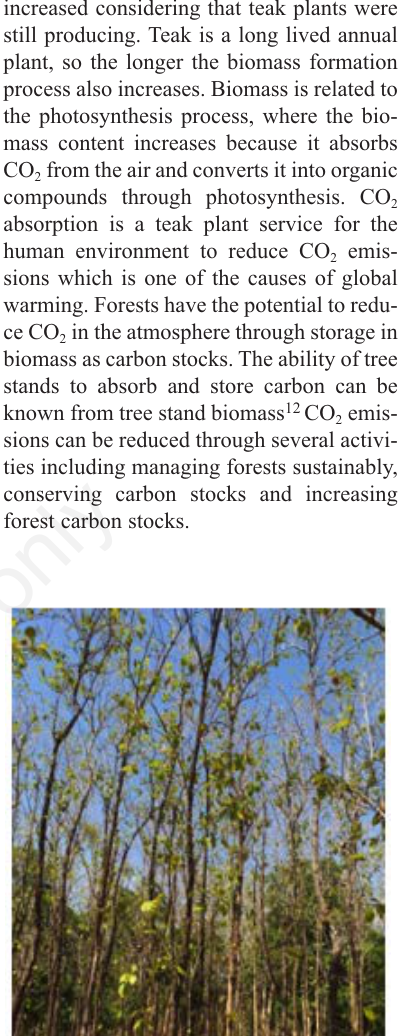
Table 1. Stem diameter, plant height, biomass, carbon stocks and CO Sample